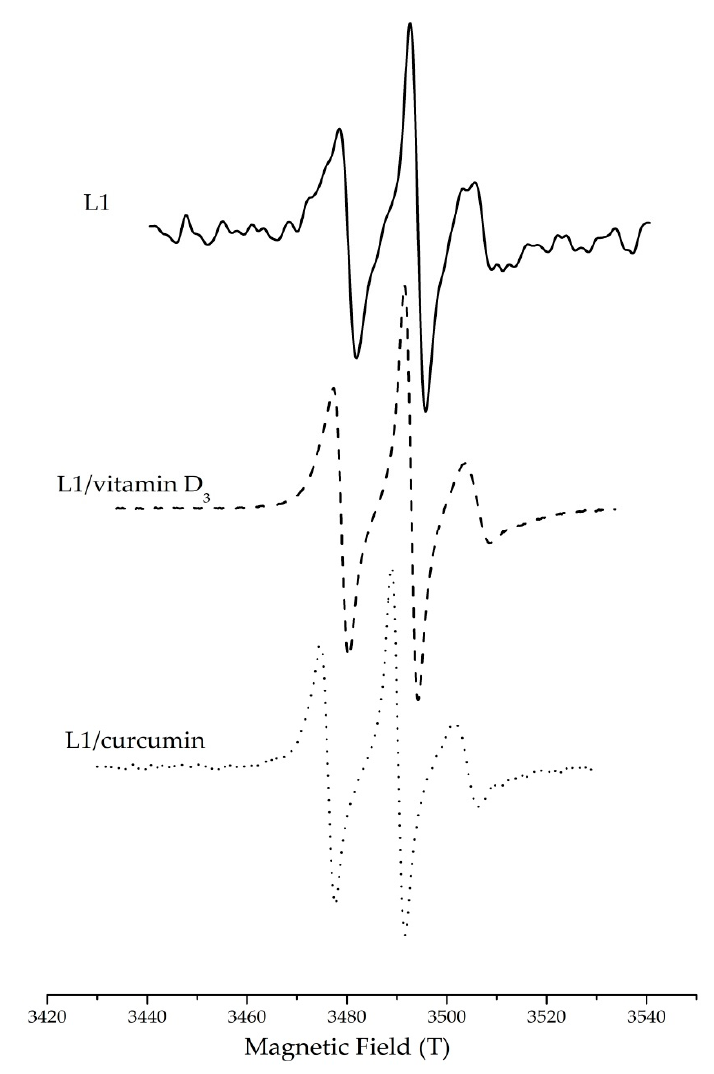
Figure 4. EPR spectra of 5-DSA in o / w nanoemulsions based on water, IPM, Tween 80, Labrasol, Maisine and Transcutol (L1) in the presence and absence of vitamin D 3 and curcumin. Table 3. Rotational correlation time ( τ R ), order parameter (S) and isotropic hyperfine coupling constant ( α N ) of 5-DSA and 16-DSA in empty and loaded nanoemulsions (L1, L1 / VD 3 , L1 / CU)